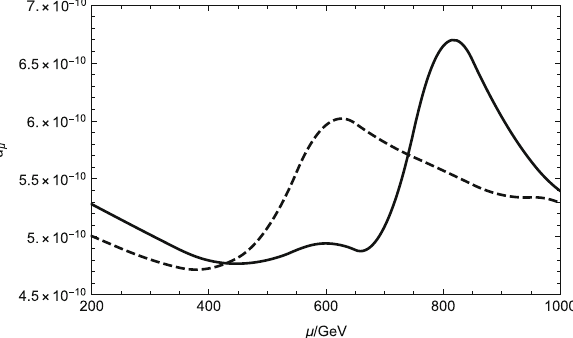
Fig. 8 The influence of μ on a μ . The dashed line expresses M 2 = 800 GeV, and the solid line expresses M 2 = 1000 GeV